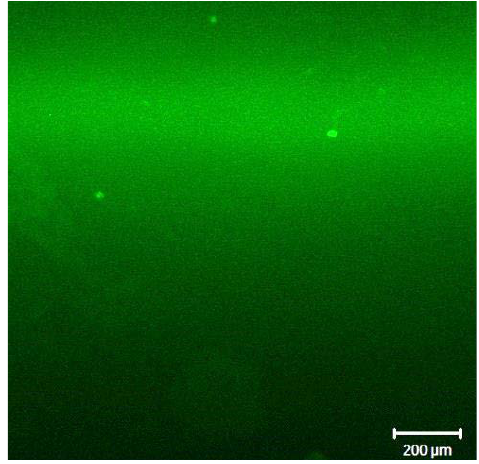
Figure 5. Fluorescent image of membrane surface deposit after Blank B experiment. Scale marker corresponds to 200 μm.